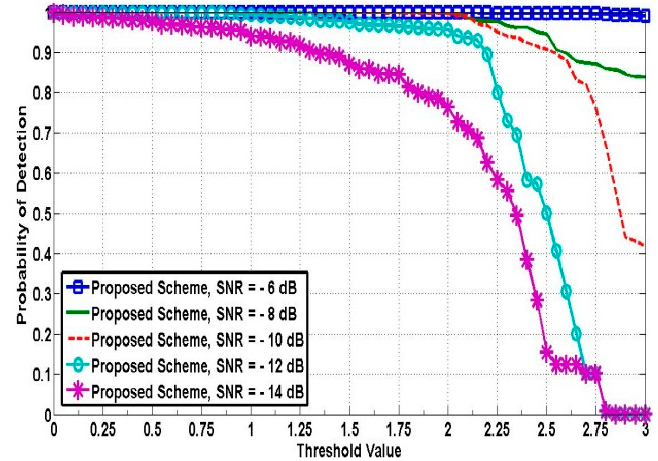
Figure 9. Detection probability versus threshold values for various SNRs.